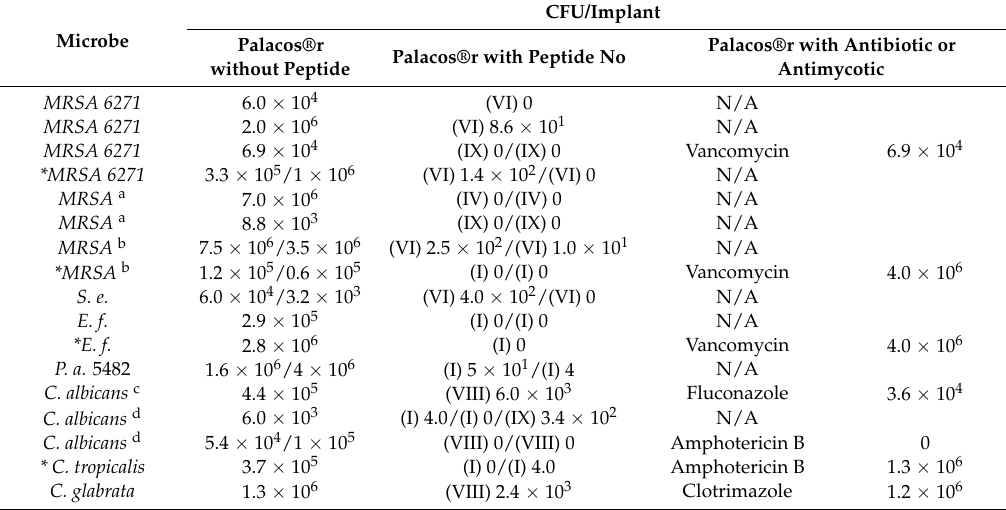
Figure 4. Peptide VI compared to vancomycin in preventing clinical isolate MRSA (M) adhesion and consequent biofilm formation on the implant’s surface made from poly(methyl methacrylate)-based bone cement (Palacos®r). The bone cement contained peptide VI (5 mg), vancomycin (5 mg) or was unloaded as a control. Bacteria infiltrated towards the implants from a hole drilled into bone tissue between them. The bars represent mean value ± SEM at least from three independent measurements. Statistical differences between groups were calculated using one-way ANOVA (* p < 0.05). Table 4. Effect of selected peptides incorporated into bone cement on the prevention of microbial adhesion and consequent biofilm formation on its